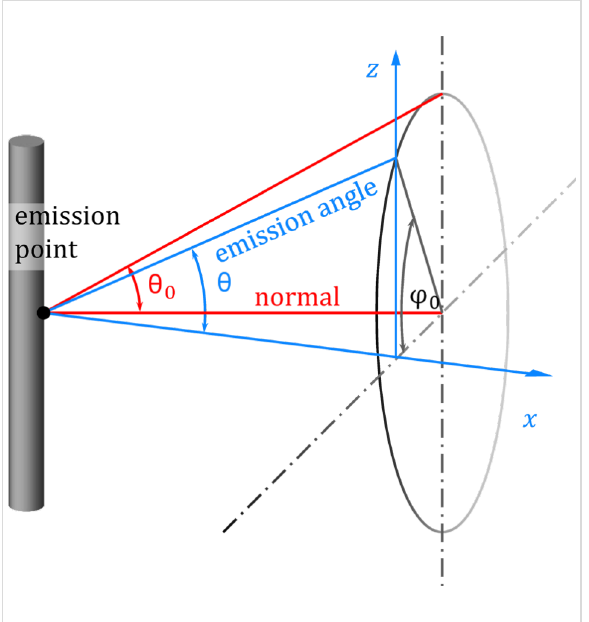
Figure 5: Schematic illustration of the angles defined above. The axis x is the direction of the transverse penetration distance with the proba- bility density function given in Equation 6, whereas the axis z is the direction along the axis of the nanocylinders.